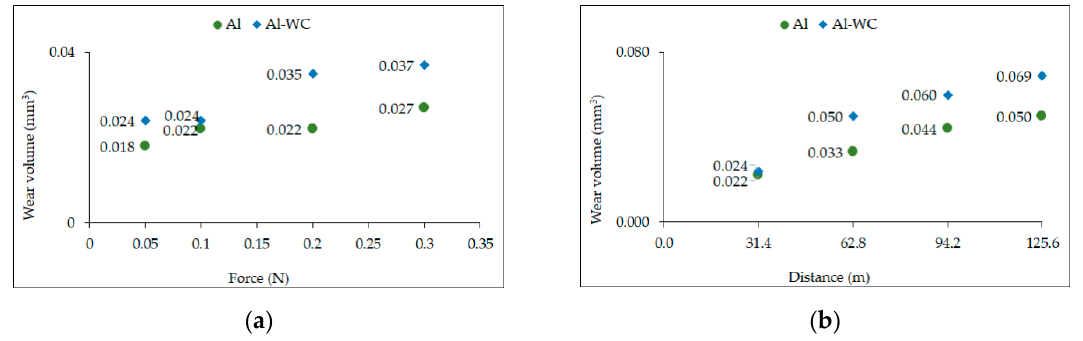
Figure 9. Wear abrasive resistance results, performed on specimens produced with 152 MPa/640 °C/2 h/high vacuum (5 × 10 − 4 Pa), ( a ) for different loads with a distance of 31.4 m and ( b ) for different distances with 0.1 N load.